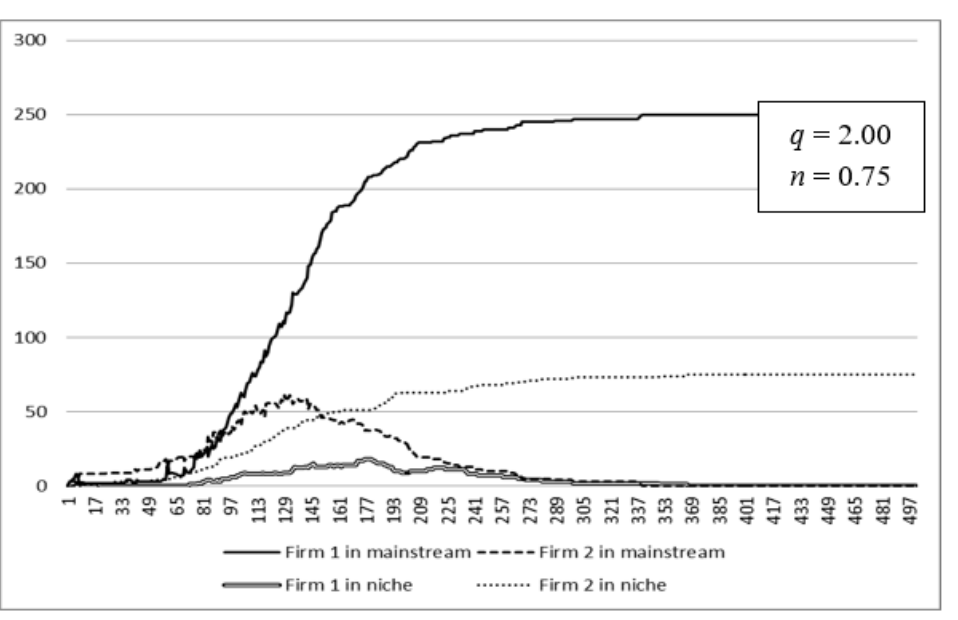
Figure 2. Competitive isolation, Firm 1 operates in mainstream and Firm 2 operates in niche segments when the network effects are weak and the preference in each segment is homogeneous.